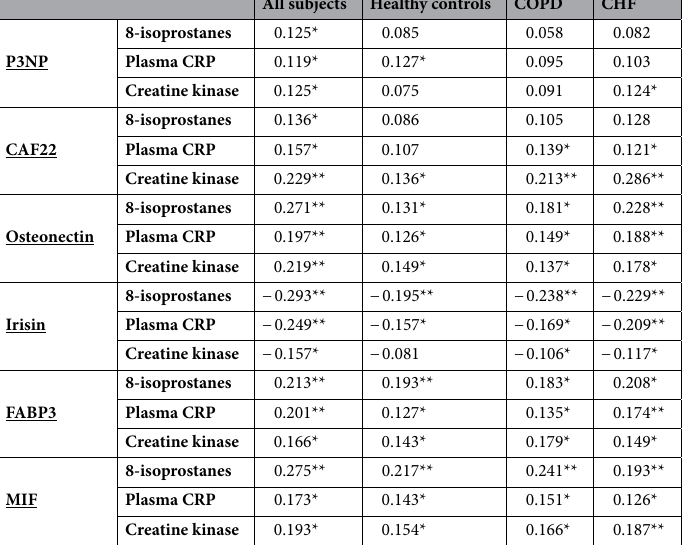
Table 3. Correlations coefficients of circulating biomarkers with plasma 8-isoprostanes, CRP and creatine kinase levels in healthy controls and patients with COPD and CHF (N = 83–87 per group). * p < 0.05, ** p < 0.001. (P3NP; amino-terminal of type III pro-collagen peptide, CAF22; C-terminal Agrin fragment-22, FABP3; fatty acid-binding protein 3, MIF; Macrophage migration inhibitory